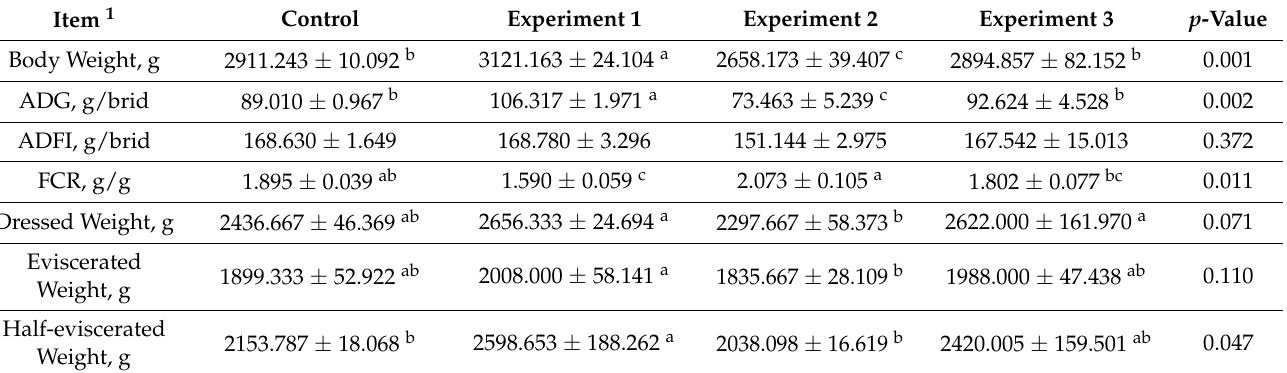
Table 2. Production performance of